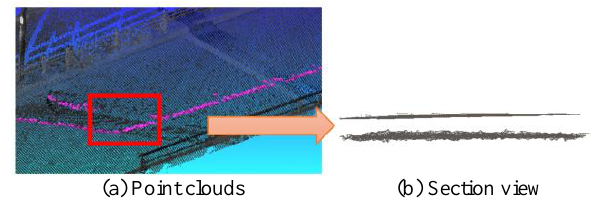
Figure 13. Duplicated measurement from different sides